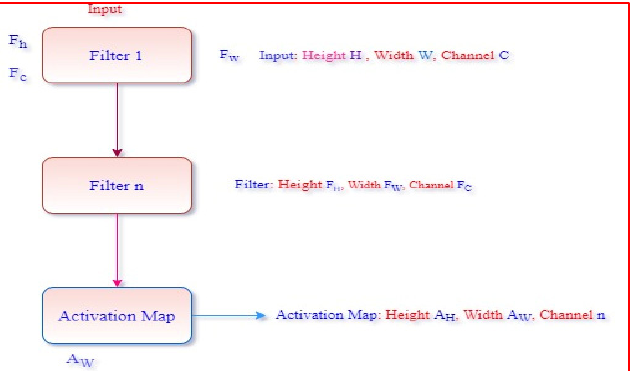
Figure 3. The complete convolution process is shown in the figure above, where different filters are applied to images before obtaining the final output [56].